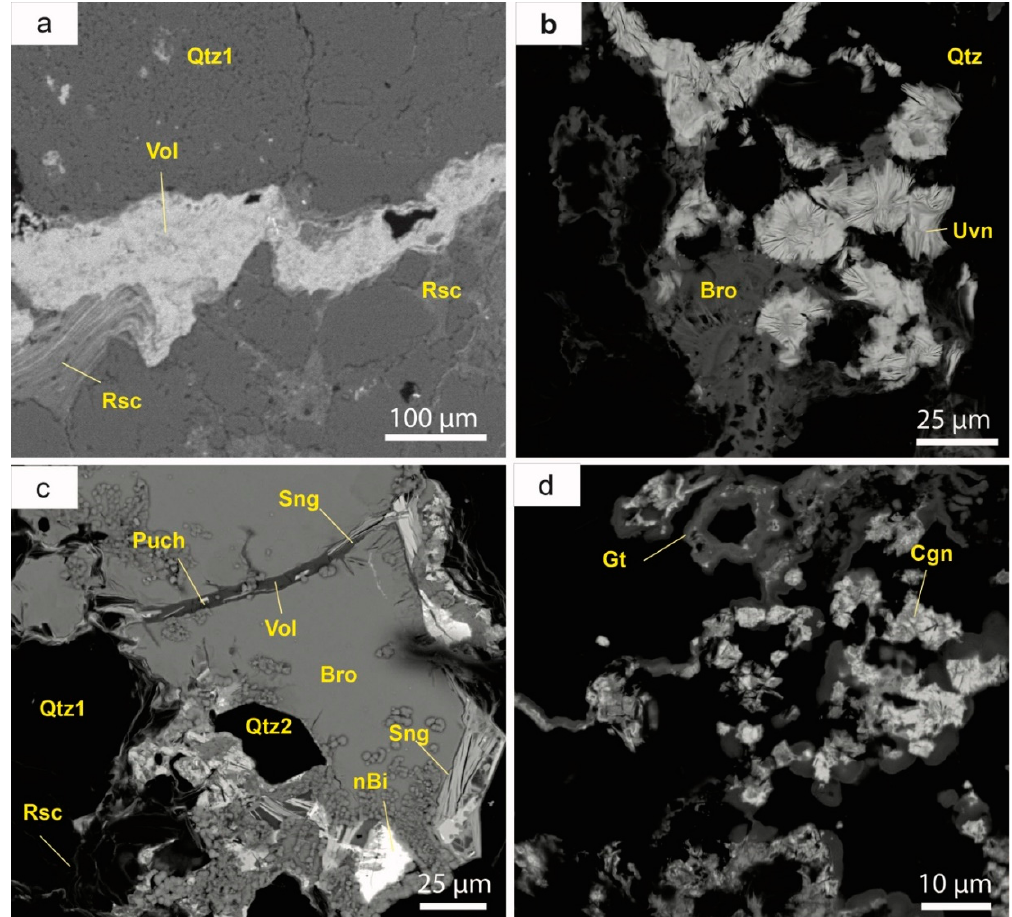
Figure 11. SEM-BSE images of secondary vanadates of the Eureka mine. ( a ) Detrital quartz (Qtz1) and interstitial roscoelite (Rsc) veined by volborthite (Vol). Note replacement of roscoelite along cleavage; ( b ) Radial aggregations of uvanite (Uvn) associated with brochantite (Bro) in secondary porosity among detrital quartz (Qtz); ( c ) Copper sulphide, with native bismuth inclusions (nBi), pseudomorphosed by brochantite (Bro) and sengierite (Sng); late veinlets filled with volborthite (Vol), sengierite (Sng) and pucherite (Puch) cut the ensemble, with syntaxial quartz cement (Qtz2); ( d ) Intergrowths of compreignacite (Cgn) with goethite (Gt), probably replacing a primary association of pyrite and uraninite (compare with the Figure 8d).